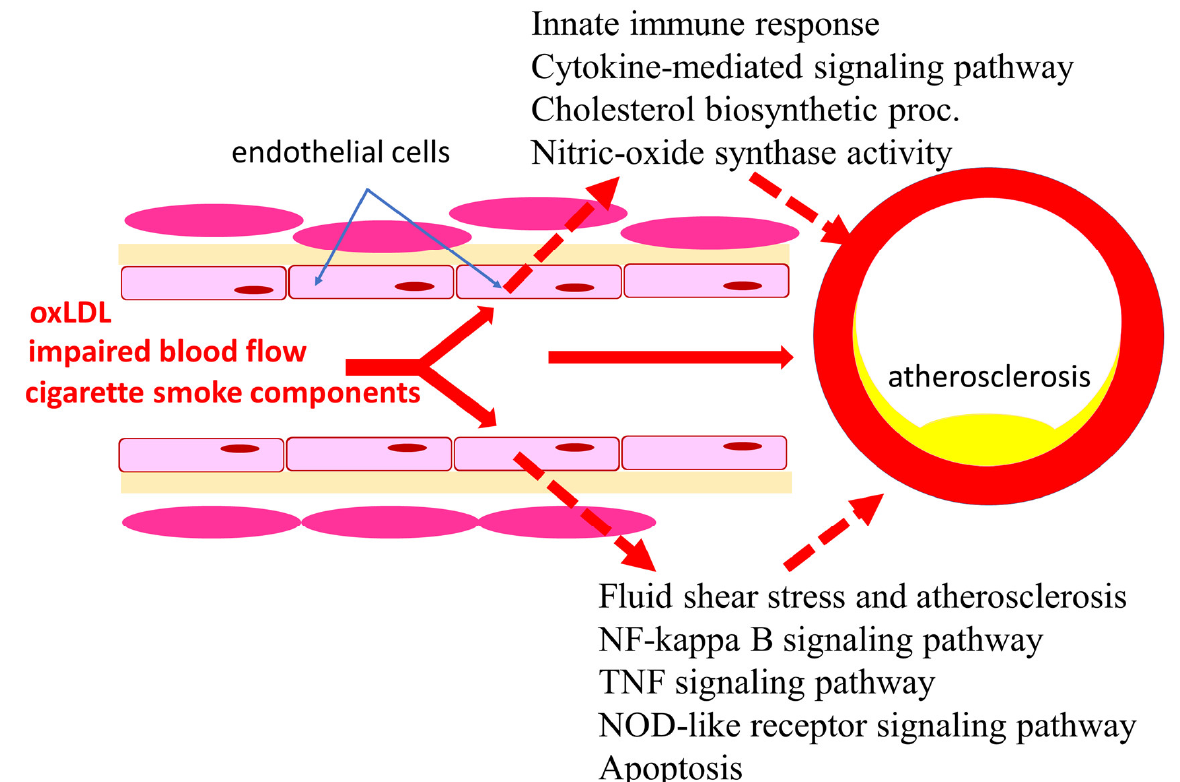
Figure 15. Significance of risk factors in the development of atherosclerosis.